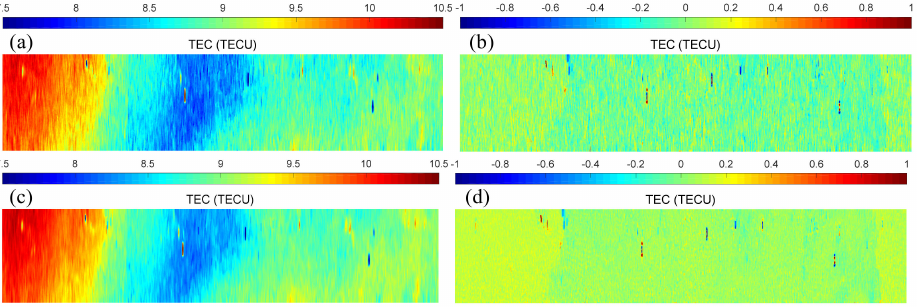
Figure 7. TEC retrieval in Kyushu based on L-band SAR ( a ) and P-band SAR ( c ), with low systematic error level. The deviations between the retrieval and the true values (Figure 1c) are shown in ( b , d